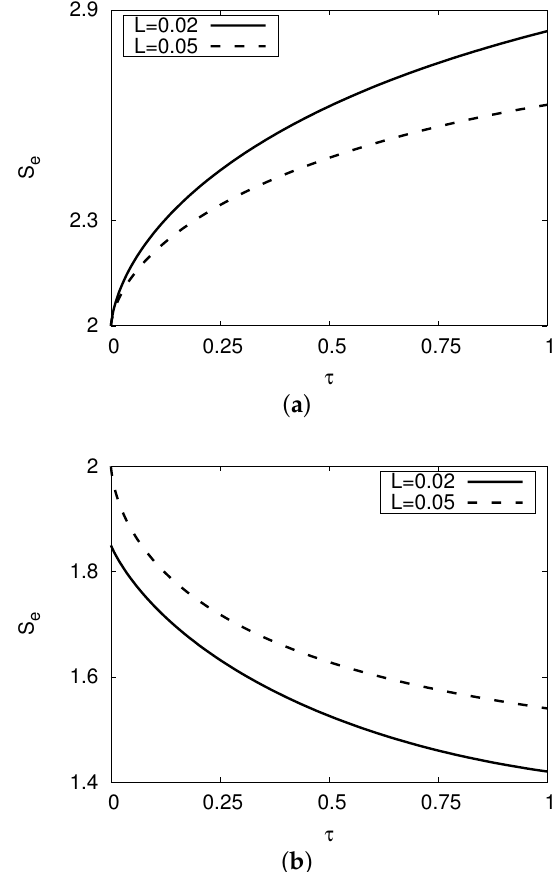
Figure 6. ( a ) Optimal exercise S e values for the American CI call and ( b ) Optimal exercise S e values for the American CI put for various expiries ( τ ). Parameters used: r = 0.05, q = 0.04, σ = 0.2, X =